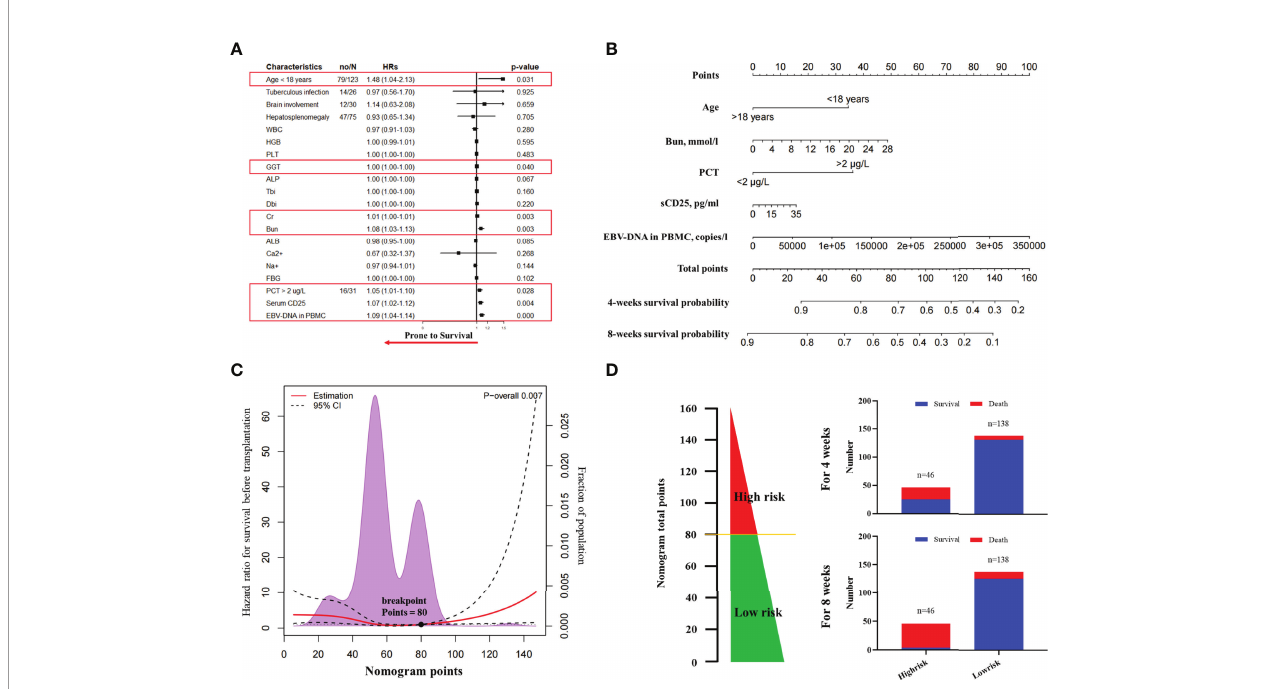
FIGURE 2 | The nomogram to predict the risk of death in induction therapy. (A) The forest plot of univariate Cox regression analysis. The result showed that age, GGT, Cr, Bun, PCT, sCD25, and EBV-DNA in PBMC were risk factors associated with the death in induction therapy. (B) The nomogram to predict the risk of death in induction therapy. (C) The breakpoints of nomogram points for the death in induction therapy. Using the regression discontinuity analysis, we identi fi ed the breakpoints of nomogram points as 80. (D) We categorized 46 patients as the high-risk group and 138 patients as the low-risk group. The histogram showed the death rate in each group. HR, hazard ratio; WBC, white blood cell; GGT, gamma-glutamyl transpeptidase; ALP, alkaline phosphatase; Tbi, total bilirubin; Dbi, direct bilirubin; ALB, albumin; Cr, creatinine; Bun, blood urea nitrogen; PCT, procalcitonin; EBV, Epstein – Barr virus; PBMC, peripheral blood mononuclear cell; CTL, cytotoxic T lymphocyte.